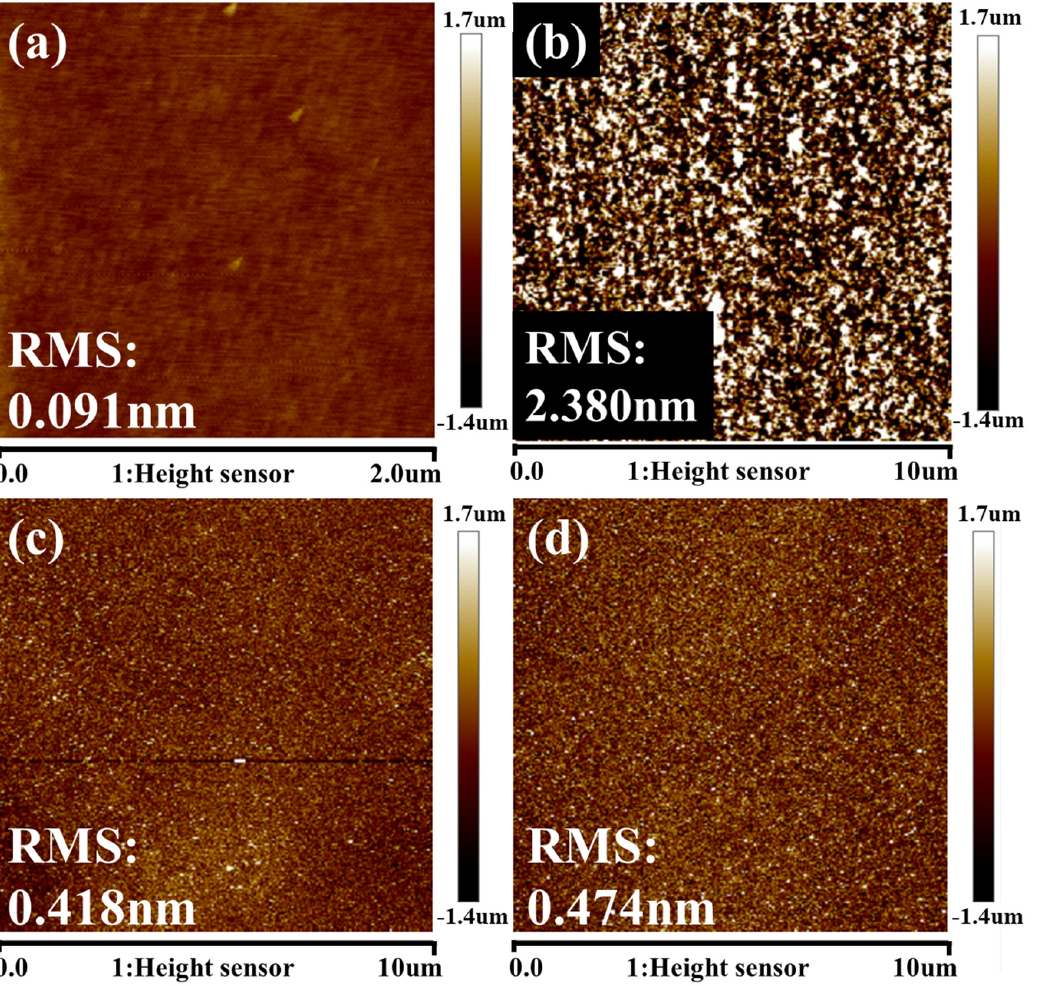
Figure 12. Typical AFM images of flat (100) Si 0.72 Ge 0.28 surfaces before and after the etching process: ( a ) as–grown; ( b ) HNO 3 :HF:H 2 O mixtures; ( c ) q-ALE with 50 cycles; ( d ) q-ALE with 30 cycles.